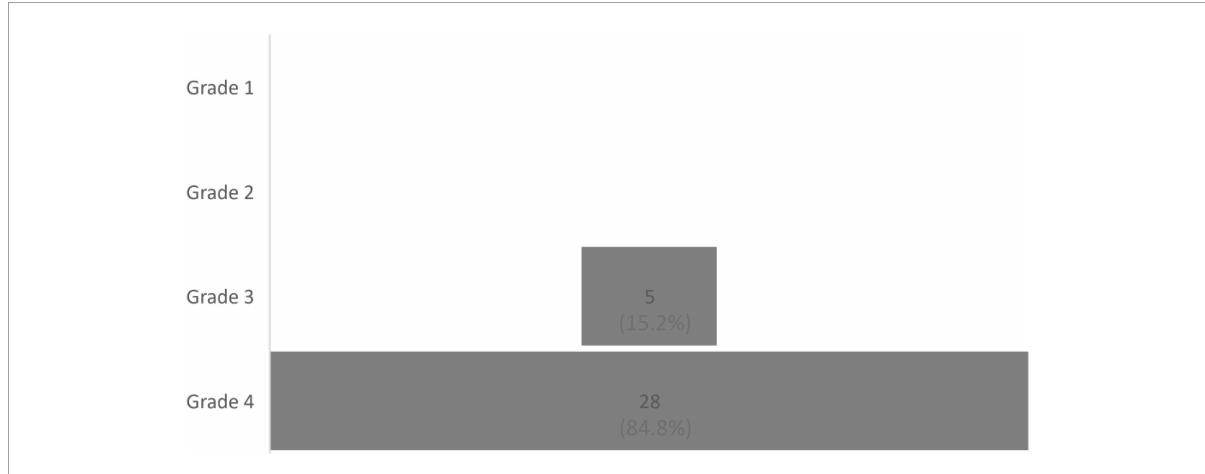
FIGURE3 Distribution of patients according to the four grades of Von Korff et al.’s Chronic Pain Grade, N =